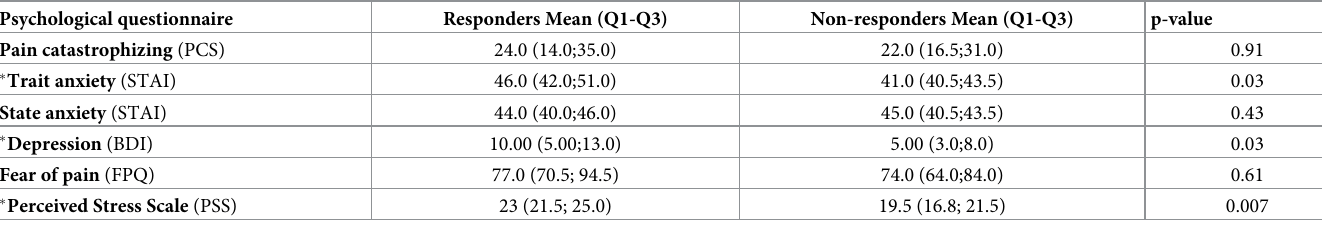
Table 5. Baseline scores of psychological questionnaires for responders and non-responders to DOMS-related MEP. Psychological questionnaire